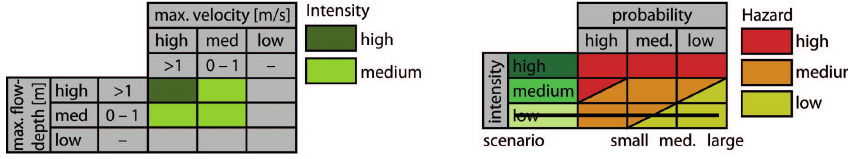
Fig. 6. Classification of debris flow intensities into two classes (left panel), and intensity-probability diagram and hazard levels (right panel) according to Raetzo et al. (2002). The low-intensity class does not exist for debris flows and is therefore marked as deleted (black line). For a better distinction of the different classes, orange is used instead of blue. See also Hürlimann et al.